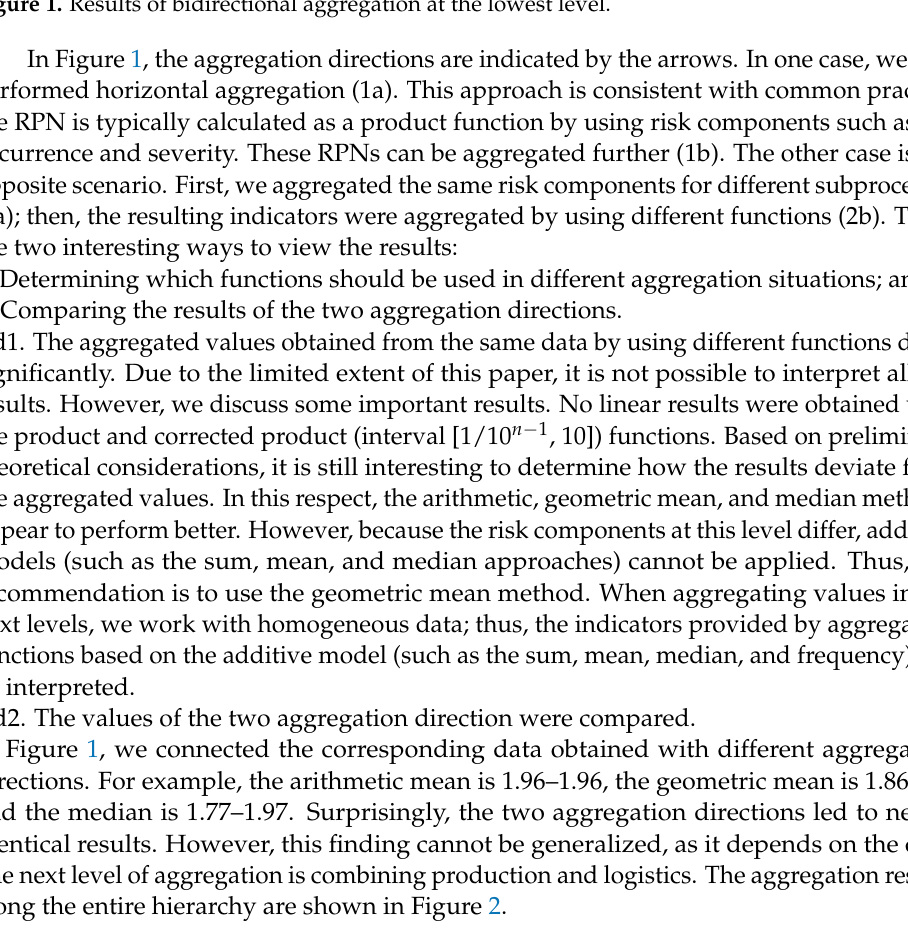
Figure 1. Results of bidirectional aggregation at the lowest